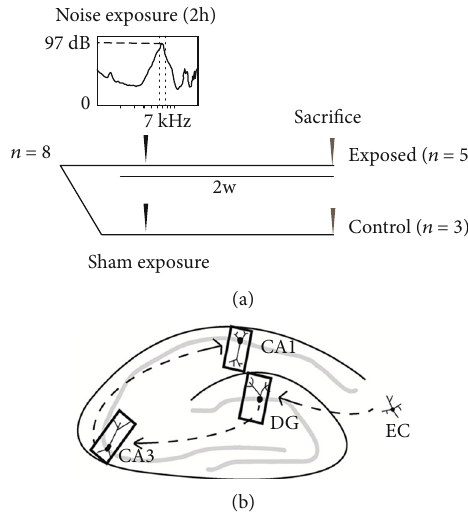
Figure 1: Experimental procedures of two-week postnoise- exposure animals. (a) Timeline of the experimental procedures for the two-week postexposure group. Eight animals were grouped into sham-exposed controls ( n = 3 ) and noise-exposed animals ( n = 5 ). Animals were exposed to a 7kHz-centered noise band at 97dB SPL for 2 hours unilaterally (left). ABR measurements were performed before, immediately after, and 2 weeks after noise exposure. Two weeks after noise exposure, animals were sacri fi ced, and brain tissue was collected. (b) Schematic diagram of hippocampal circuit. Arrowheads in dashed line show information fl ow in the hippocampal trisynaptic circuit. Black rectangles point out where images in the dentate gyrus (DG) and areas CA3 and CA1 were taken for immunohistochemistry. EC: entorhinal